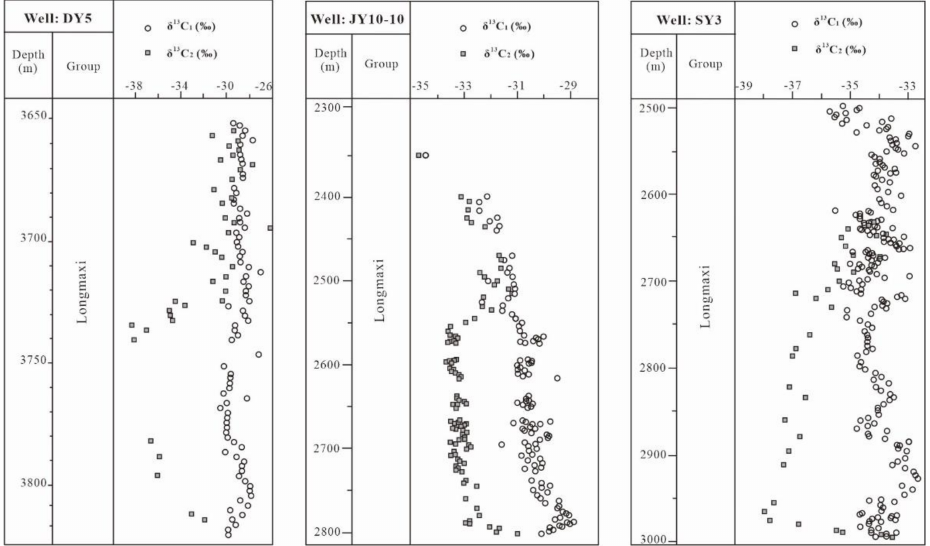
Figure 5. δ 13 C 1 and δ 13 C 2 variation of mud gases with increasing depth (cited from reference [26], with some